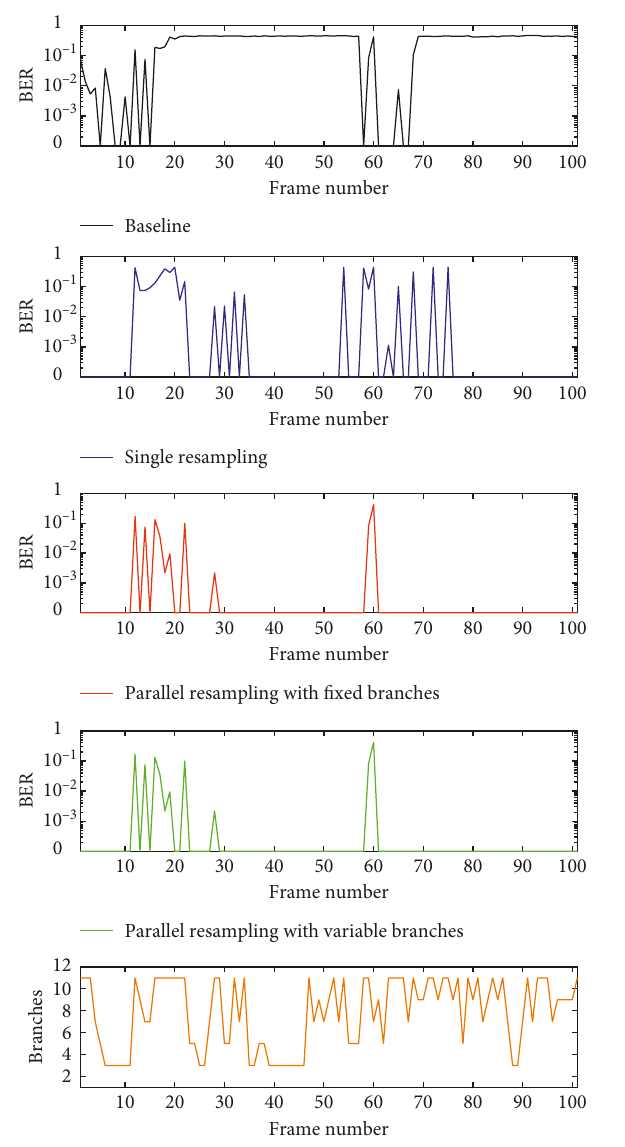
Figure 16: Results of BER and number of branches in Test 2.